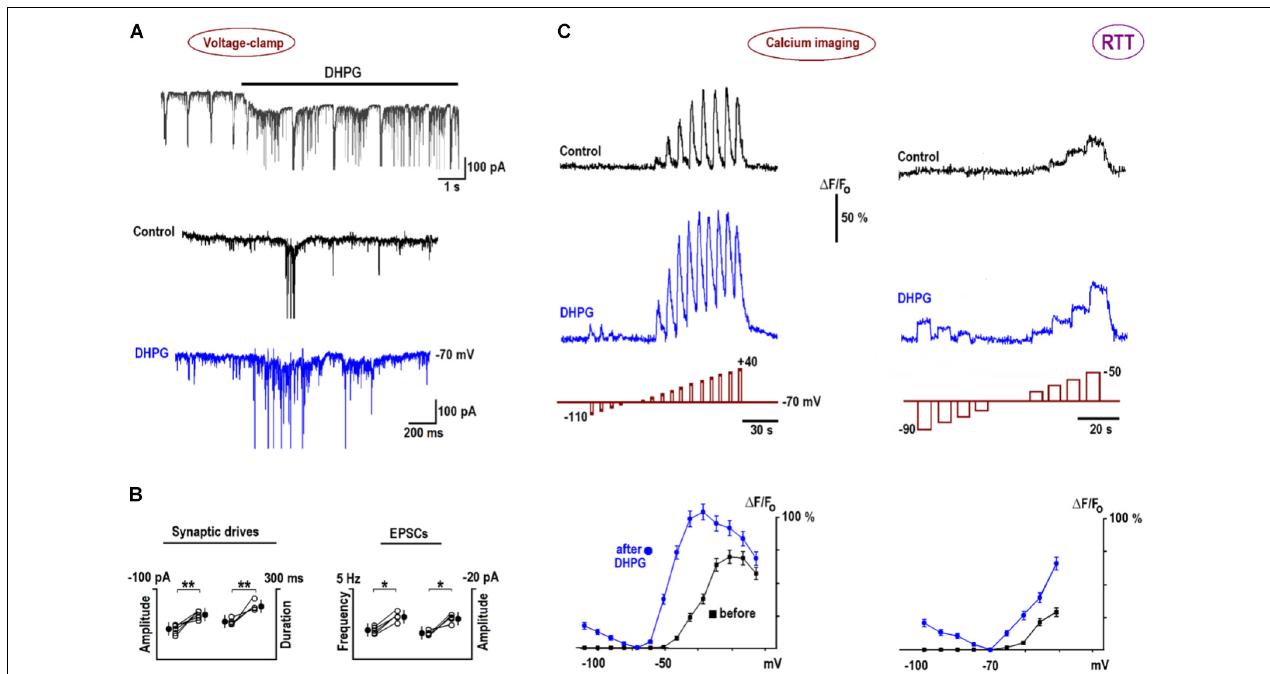
FIGURE 6 | DHPG effects on neuronal activity and calcium influx in RTT. (A) DHPG induced an inward current and potentiated excitatory synaptic currents and drives in whole-cell voltage-clamp experiments. (B) Group summary of these experiments. (C) Potentiation of voltage-triggered calcium increases by DHPG (the voltage steps are depicted below respective traces; note different pulse durations and voltages in the left and right panels). Calcium transients were measured before and 10 min after application of 1 µ M DHPG and peak [Ca]-V dependencies are plotted in the bottommost graphs in panel (C) . Note calcium increases during hyperpolarizing steps after DHPG, which can be ascribed to activation of calcium-permeable TRPC channels (see also text). Calcium imaging in WT is shown in Supplementary Figure S2B